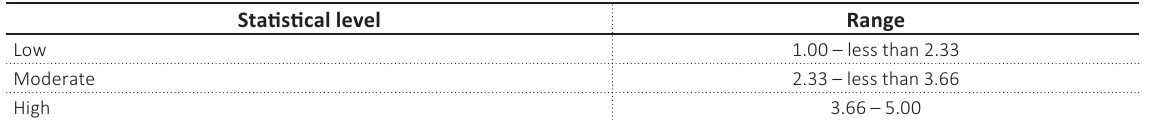
Table 1. Level of the respondents’ attitudes